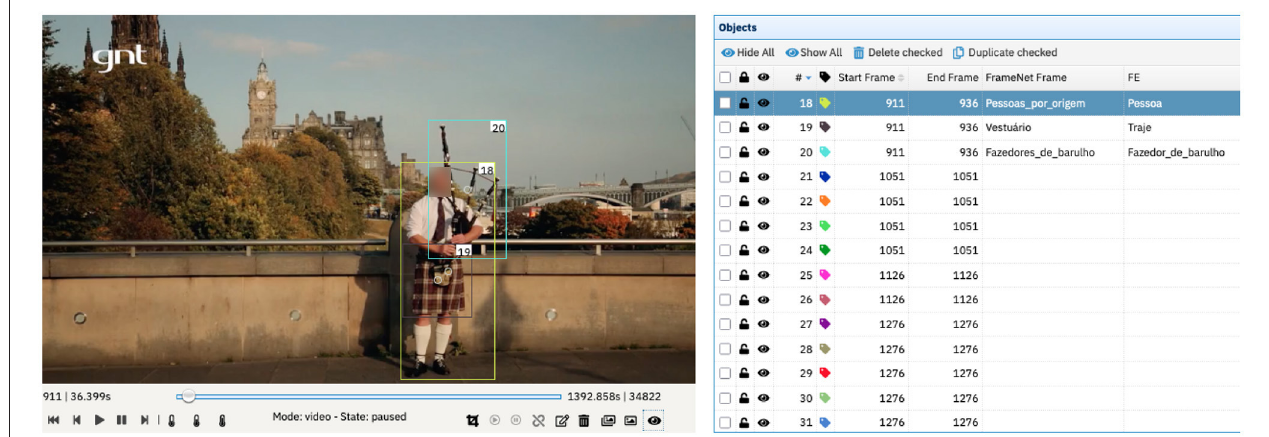
FIGURE 9 | Example of video annotation for frames and FEs in Charon. Streetscene image reproduced with permission from GNT.